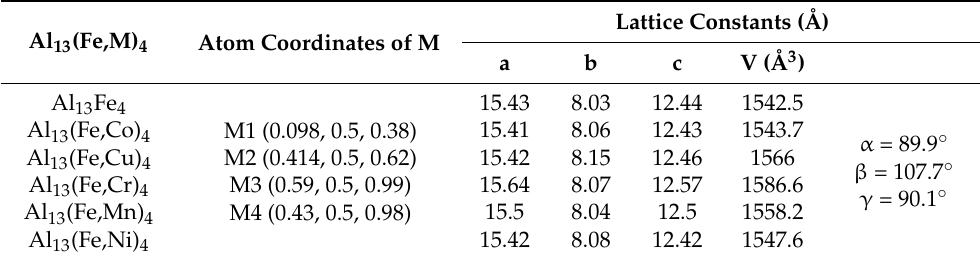
Table 2. Structural information, lattice parameters (Å), cell volume (Å 3 ), and formation enthalpy (E f ) (at 0 K) for M occupying Fe sites in the θ -Al 13 Fe 4 phase.